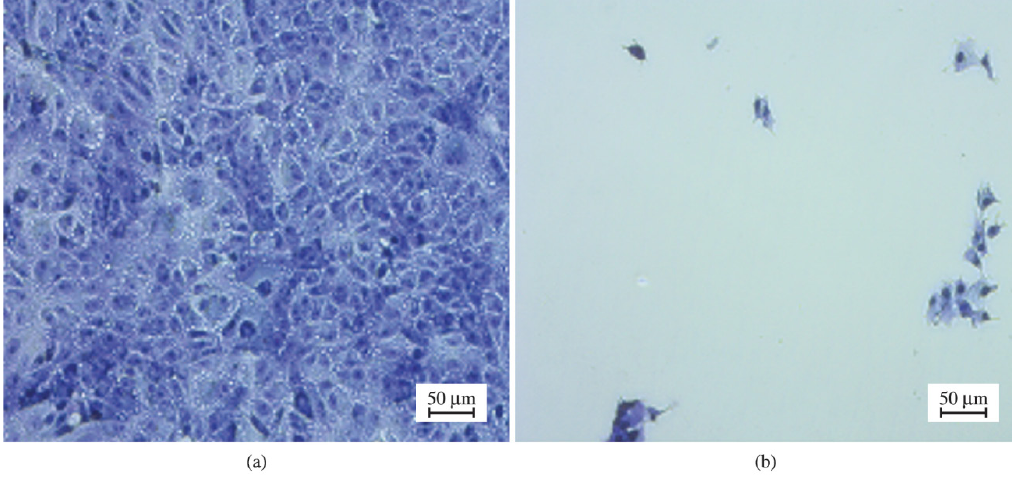
Figure 12. Test of cytotoxicity controls. (a). noncytotoxic control, confluent monolayer of cells. (b) Control cytotoxic few cells present, with very dense nucleus, cellular prolongations and presence of debris. Cells stained with toluidine blue, increased 200x.